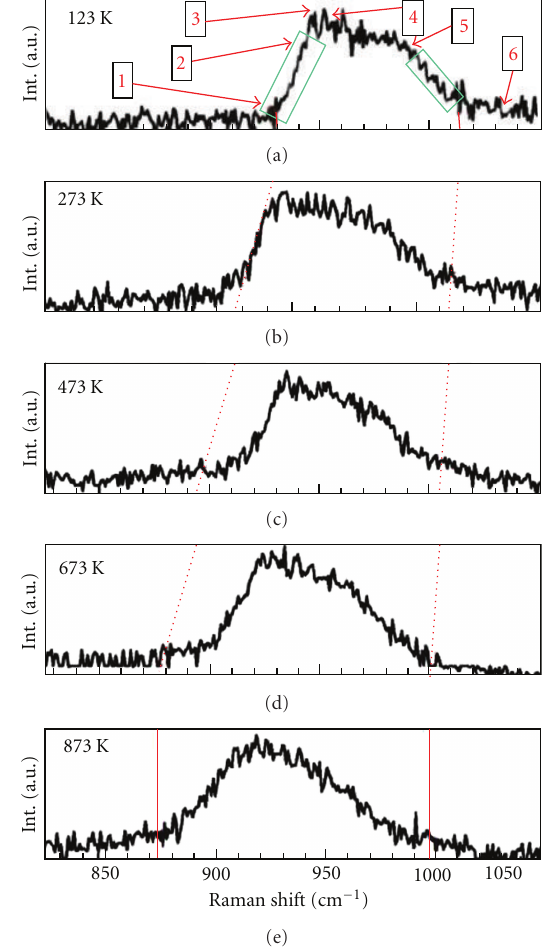
Figure 12: Second-order Raman spectra of Si nanowires TO phonons as a function of temperature. The numbers in the top panel (1, 2, 3, 4, 5, and 6) refer to Brillouin zone points X , Q , S 1 , W , L , and Γ , respectively. Temperature-dependent second-order Raman spectra of Si obtained using 632.8 nm laser excitation [113].